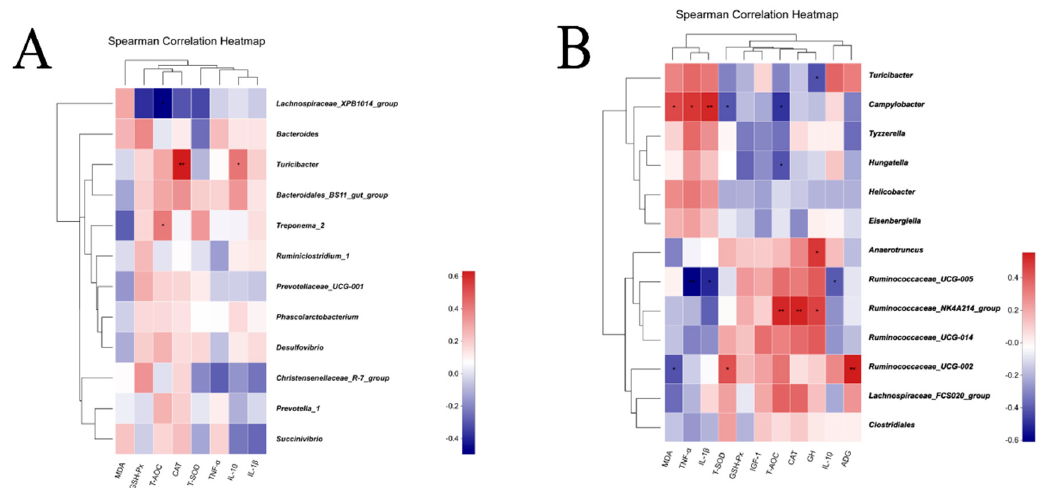
Figure 6. Spearman correlation analysis between differential genera and oxidative stress, inflammatory marker and growth performance of ( A ) the sows and ( B ) their piglets. n = 8 per group. (Please replace with a sharper image. (Minimum 1000 pixels width/height, or a resolution of 300 dpi or higher).